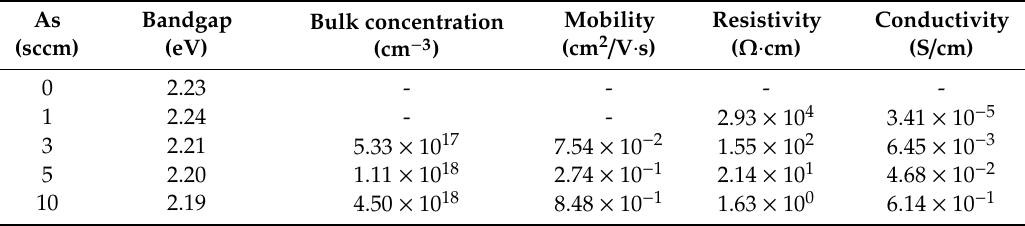
Table 1. Electrical parameters from Hall-effect measurements on ZnTe:As thin film samples deposited on uncoated glass substrate with different amounts of As.